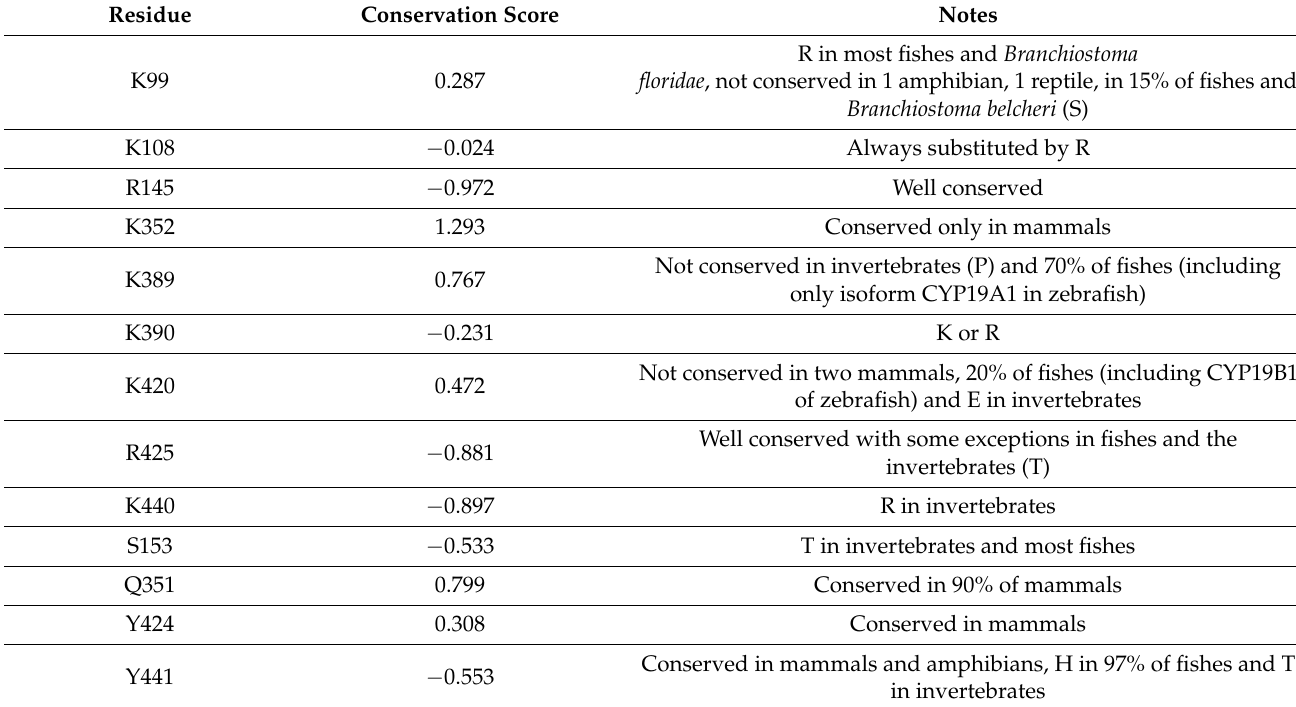
Table 2. Conservation of the residues involved in the interaction with the redox partner in human aromatase. The scores are normalized, so that the average score for all residues is zero and the standard deviation is one. The lowest score represents the most conserved position in a protein. For reference, the lowest score associated with a fully conserved residue was − 1.103, whereas the highest score obtained for a nonconserved residue in human aromatase was +2.844.